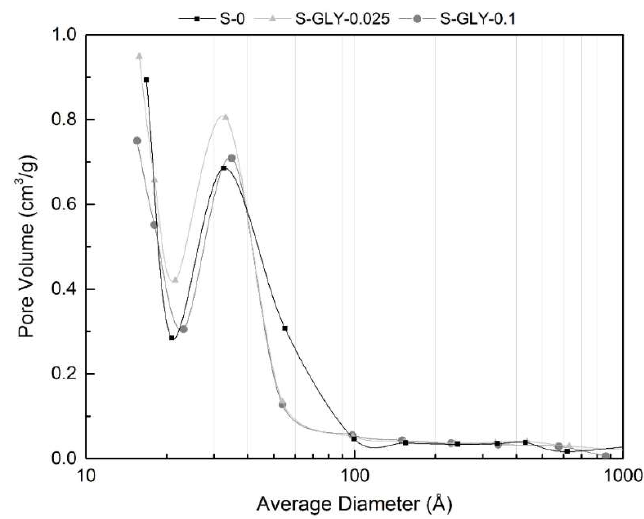
Figure 7. Pore size distributions of aerogel-like materials with and without GLY additive.